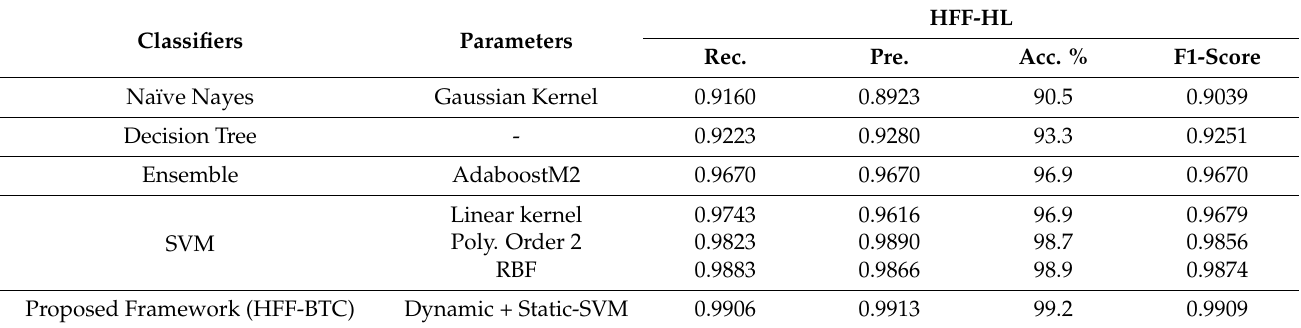
Table 7. Performance comparison of proposed HFF-BTC with existing ML